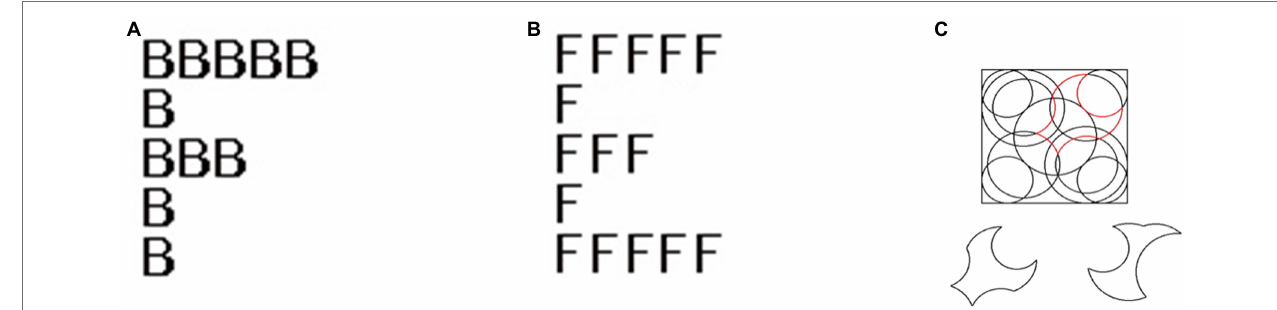
FIGURE 1 | Sample stimuli or Navon Figures (NF) for priming. Instruction: “Does the stimulus contain an F or an H?”; (A) global priming, (B) local priming, and (C) presents an example stimulus of the Figure-Disembedding Task with a complex figure at the top (with shape inserted in red for illustration purposes) and two answer options at the bottom (the left shape would be the correct answer